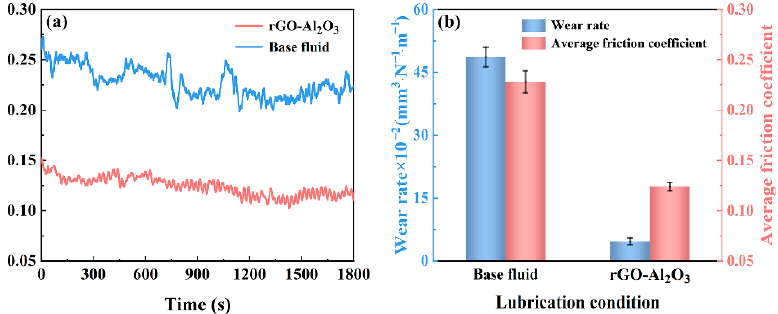
Figure 7. Tribological behavior of base fluid and rGO-Al 2 O 3 nanofluid: ( a ) friction coefficient–time curves and ( b ) wear rate and average friction coefficient. curves and ( b ) wear rate and average friction